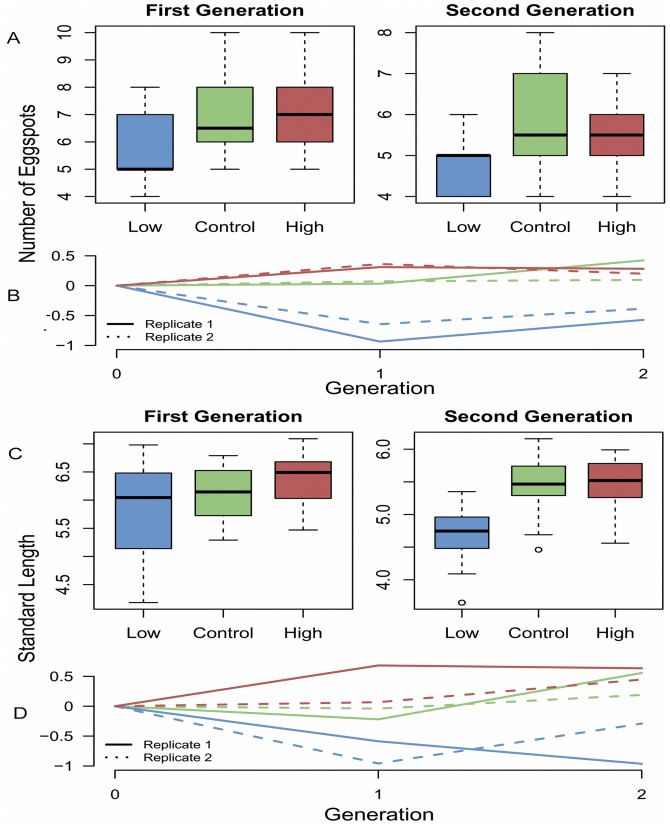
Response and correlated response to selection.Response of eggspot numbers (A,B) and correlated response of body size (C,D) to two generations of artificial selection. (A) Boxplots of eggspot numbers of each selection line. (B) Selection response trajectories. Eggspot numbers were scaled (z score) to eliminate the difference in range between the generations. Plotted values are the means of each replicate. (C) Boxplots of standard length of each line. (D) Correlated response trajectories of standard length values scaled (z score) to eliminate the difference in range between the generations and sexes. Values plotted in the line plots (B and D) are the means of each replicate.